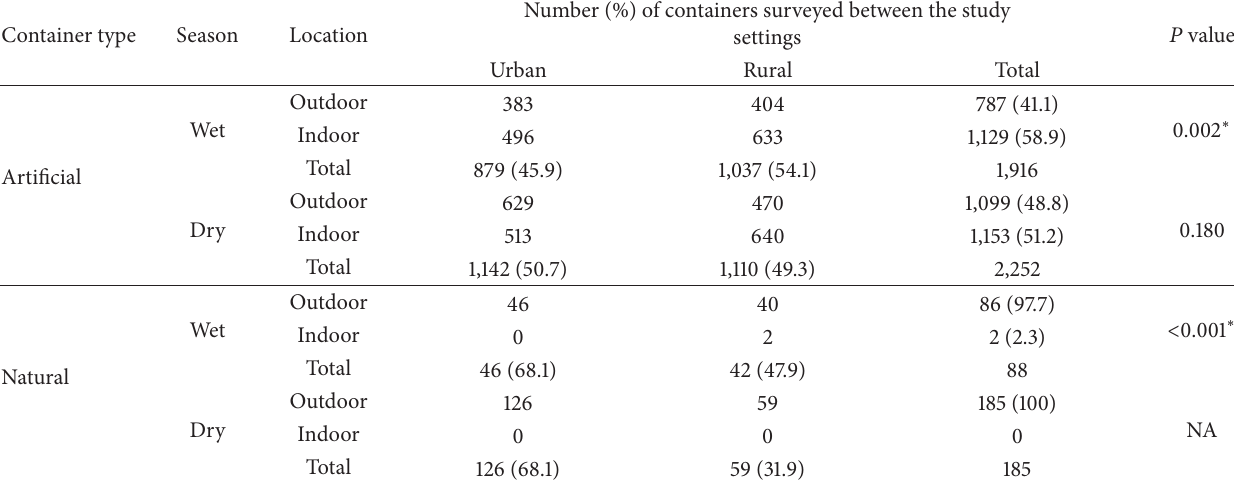
Table 1: Seasonal and geographical distributions of water-holding containers.